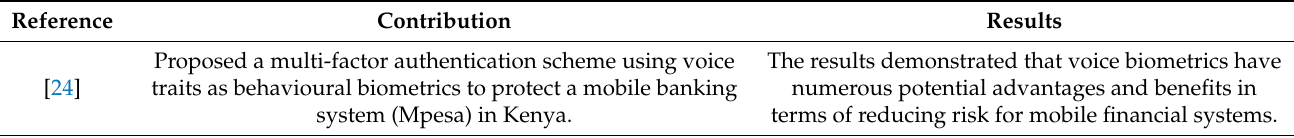
Table 1. Comparison between the current and relevant previous